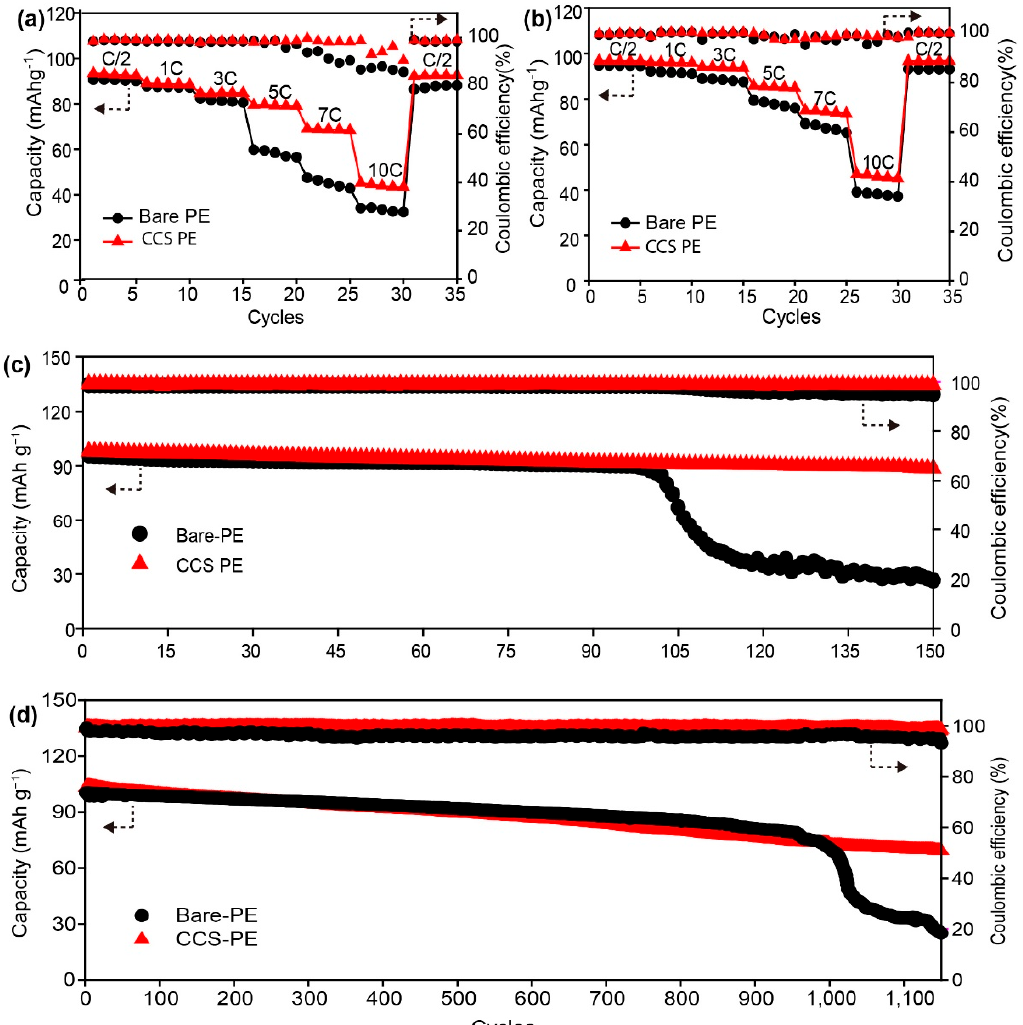
Figure 8. The rate capability of; ( a ) half cells, and ( b ) full cells at varying rates for both charging and discharge with the Coulombic efficiencies. Cycling performance of; ( c ) Li/LMO half cells and ( d ) Graphite/LMO full cells with the Coulombic efficiencies.